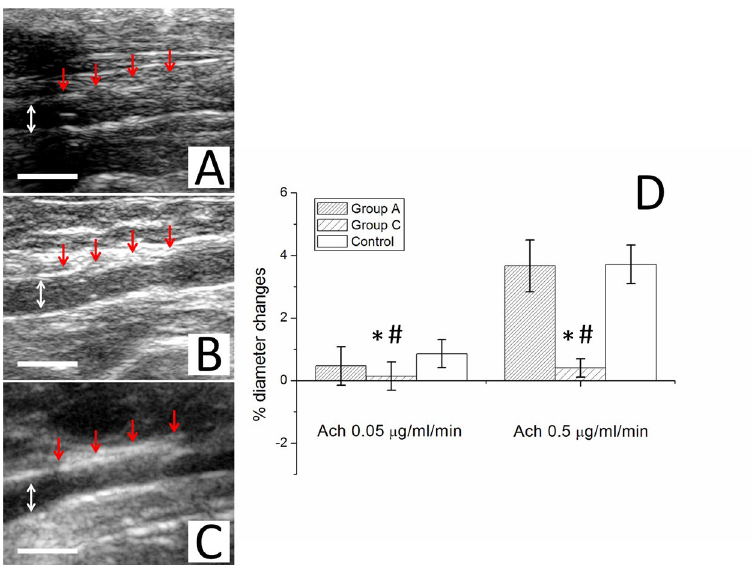
Figure 14. One week ( A ) and 4 weeks ( B ) group A; C: group C) following the procedure, no migration and patent abdominal aorta were observed for the implanted stent (arrow) using the vascular ultrasound. (Scale bar = 5 mm) ( * P < 0.05 group A versus group ( C ) in post hoc analysis; # P < 0.05 group C versus control group in post hoc